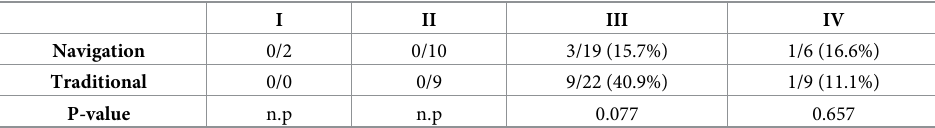
Table 2. Penetration of suture anchors (penetrating screws/total screws).